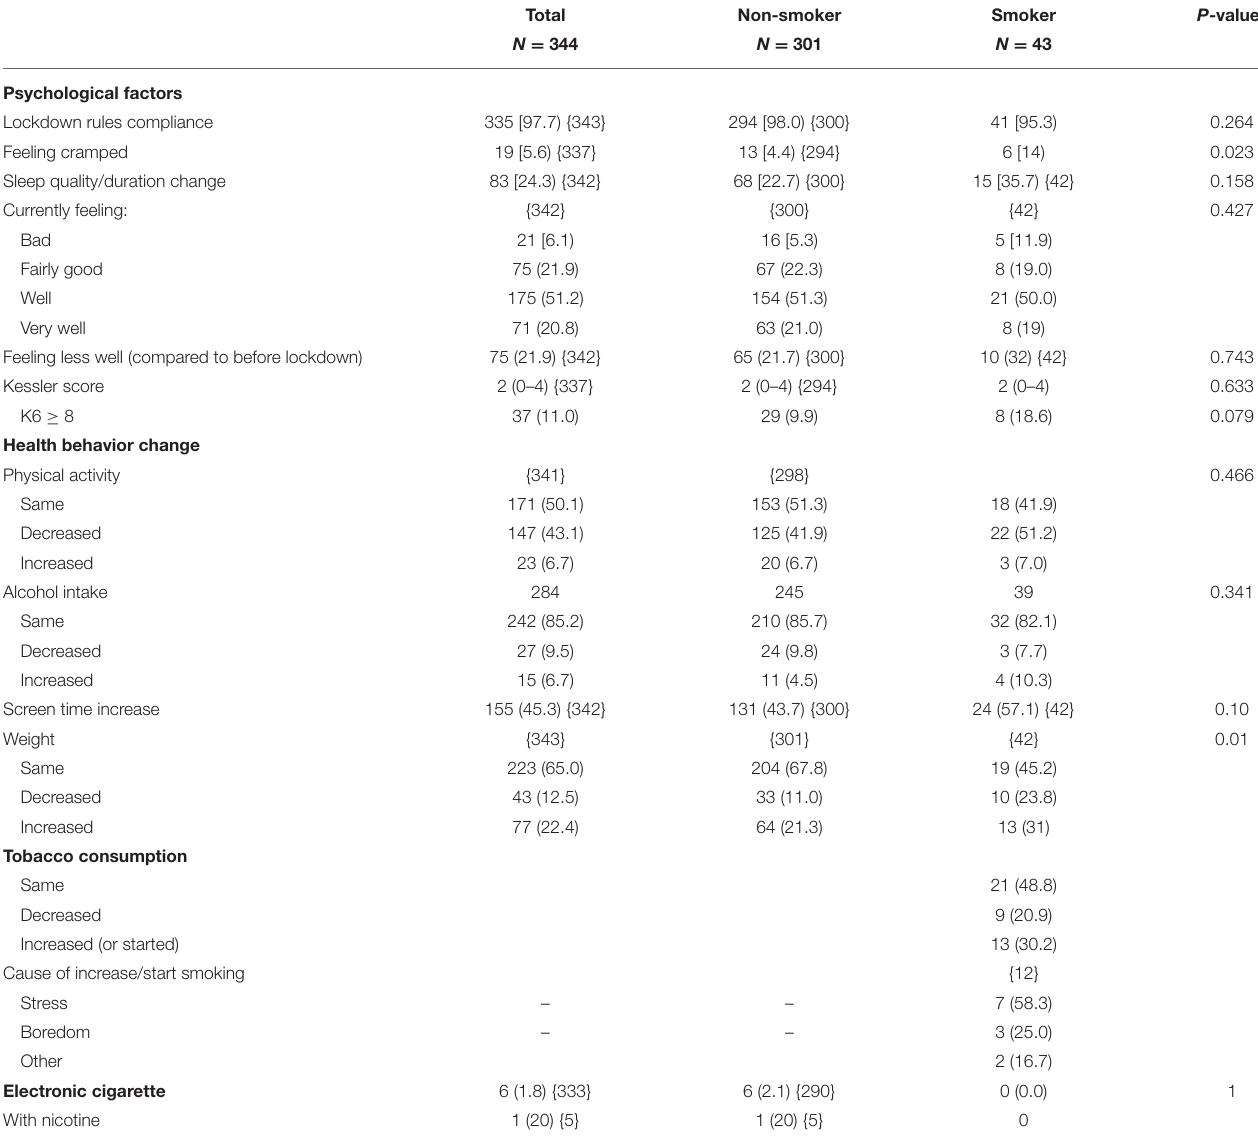
TABLE 3 | Patients feeling and behavior according to smoking status during